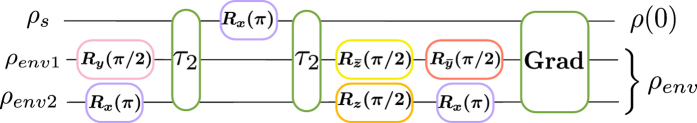
Quantum circuit representing the NMR pulse sequence for the state preparation of the initial state of system and environment given by ρ(0) ⊗ ρenv.The boxes with the symbols Rα(θ) indicate that a rotation of the angle θ on that particular spin was performed around the α direction and . The boxes with the symbol τ2 represent a free evolution of the system and environment for a period of time τ2. The box with the symbol Grad stands for the magnetic field gradient that is applied in the z-direction.